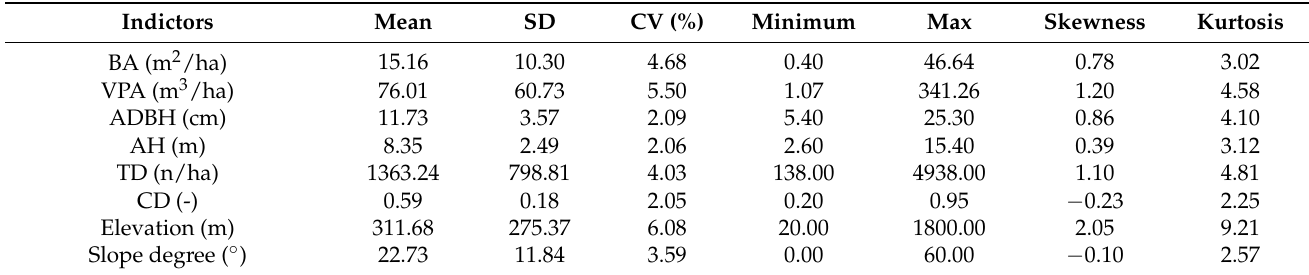
Table 5. Mean, standard deviation (SD), coefficient of variation (CV), minimum, maximum, skewness and kurtosis of stand structure and topography.